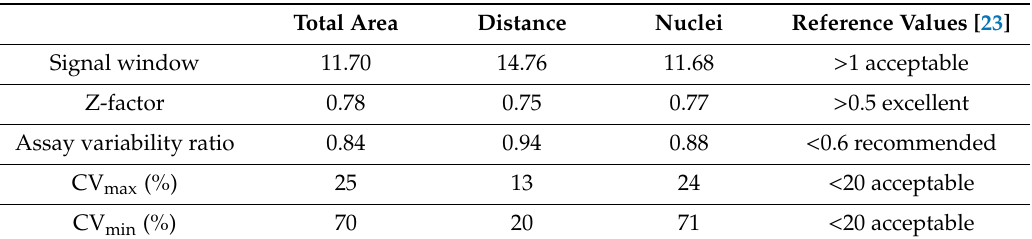
Table 1. Assay performance characteristics of the quantified parameters for iPSC-ECs. The CV at maximum (CV max ) and minimum signal (CV min ) are derived from 0 nM and 50 nM respectively. Recommended values as found in Iversen et al. [23].